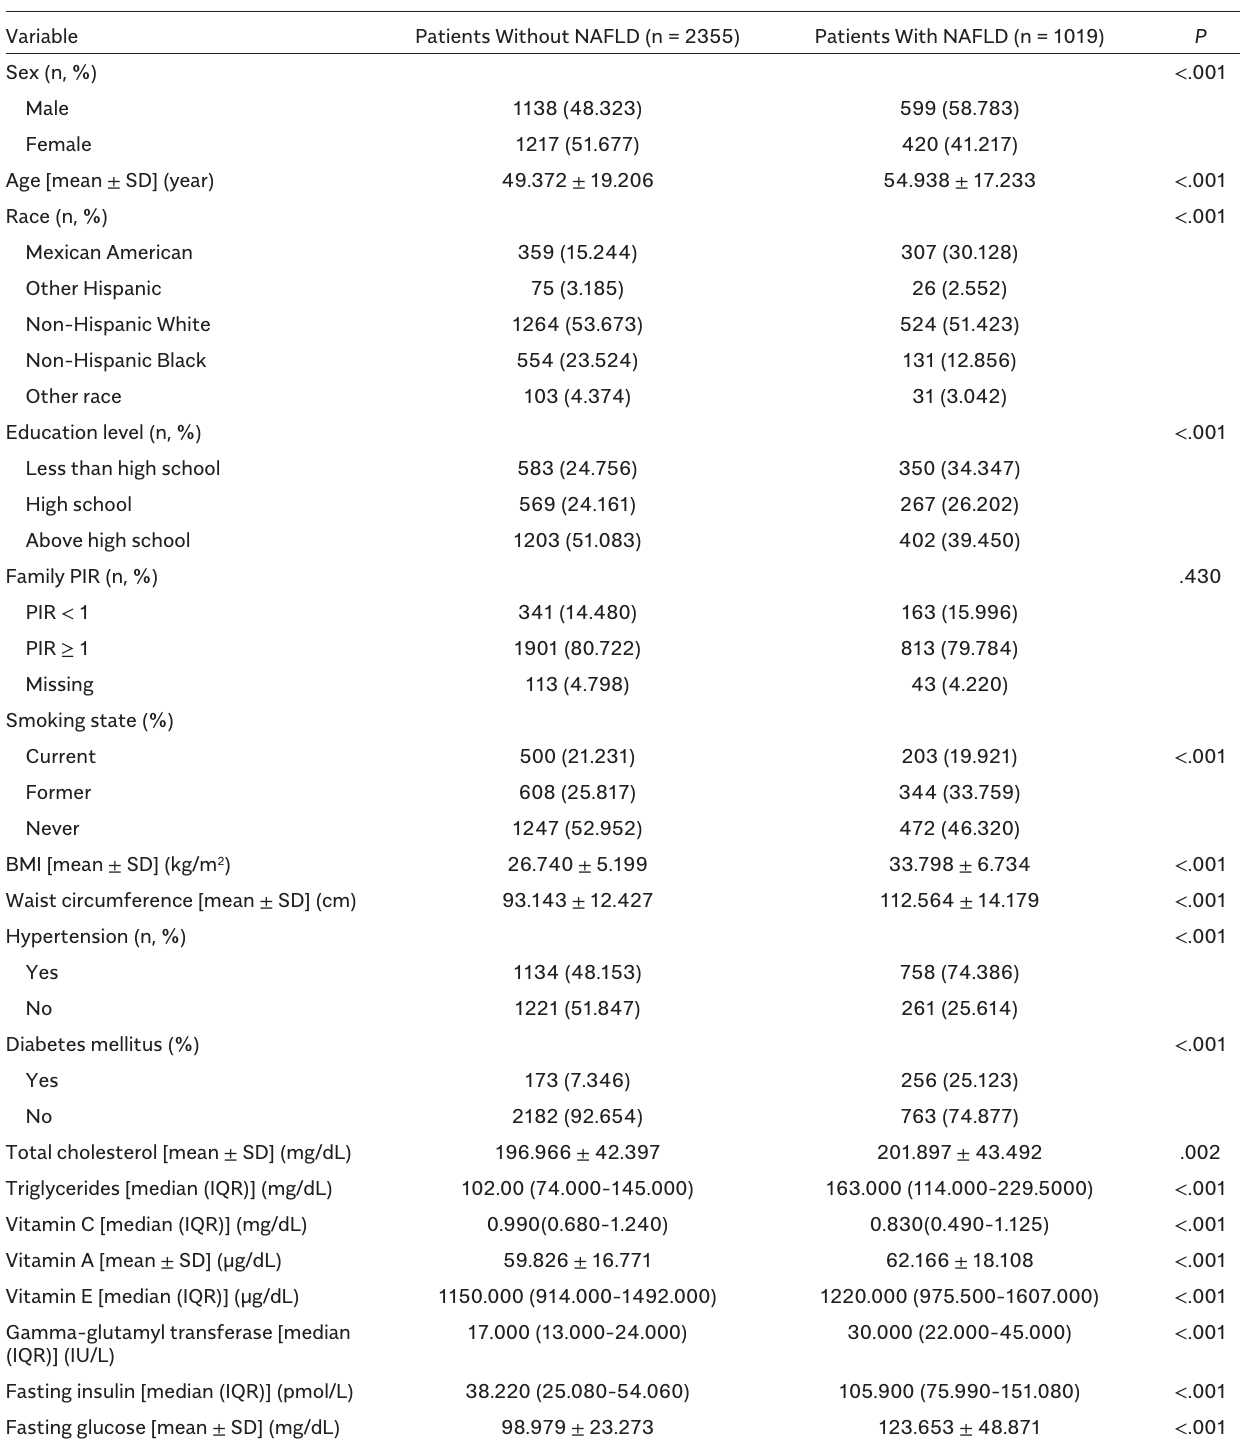
Table 1. Basic Characteristics of the Study Population Variable Patients Without NAFLD (n = 2355) Patients With NAFLD (n =